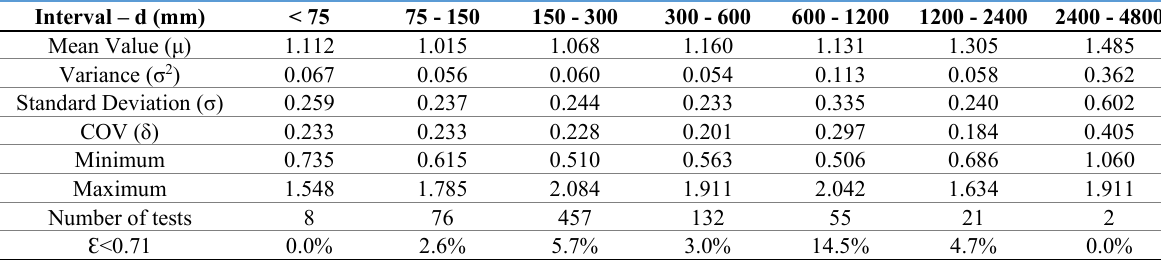
Table 5. Statistics of model error by effective depth range for the proposed